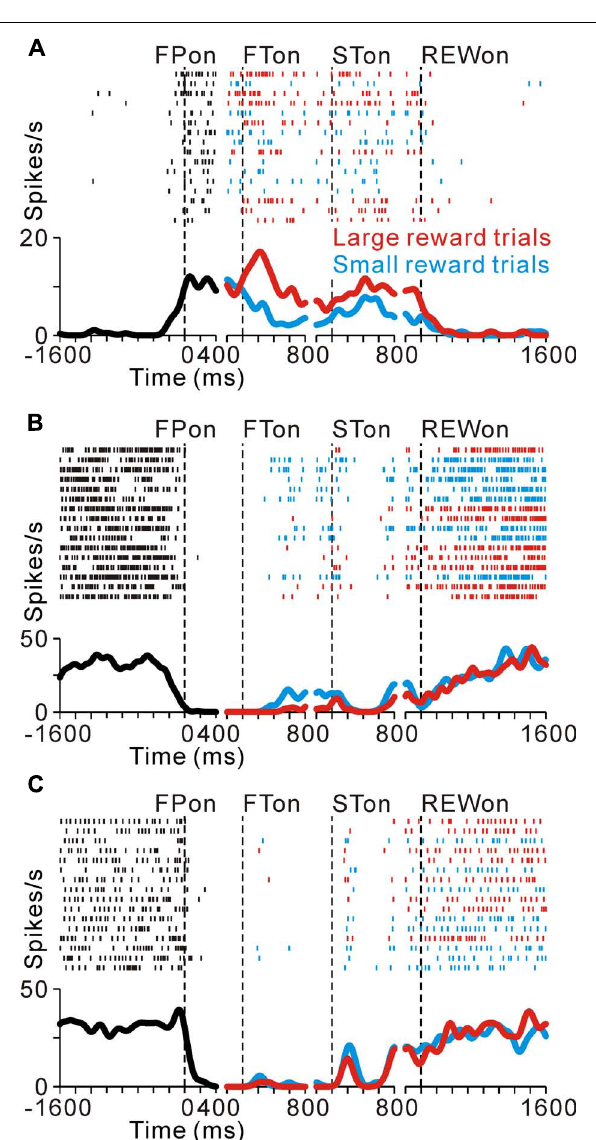
FIGURE 2 | Reward-related activity modulation of the tonic excitatory and suppressive neurons. The rastergrams and spike density functions are shown in four sections. From left to right, the data are aligned to the time of FP onset, FT onset, ST onset, and reward delivery, respectively.The colored rasters and traces indicate the large reward trials (red), small reward trials (cyan), and all trials (black). (A) This representative neuron exhibited an increase in tonic activity during the task period, and showed greater activity for the large reward-predicted cue than for the small reward-predicted cue. (B) The activity of this representative neuron decreased during the task period, and showed smaller activity for the large reward-predicted cue. (C) This representative neuron also showed a decrease in tonic activity during the task period, but showed no reward prediction-related activity modulation.